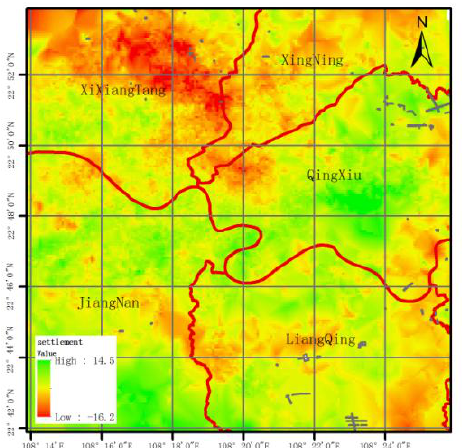
Figure 5.Construction monitoring spots and settlement result